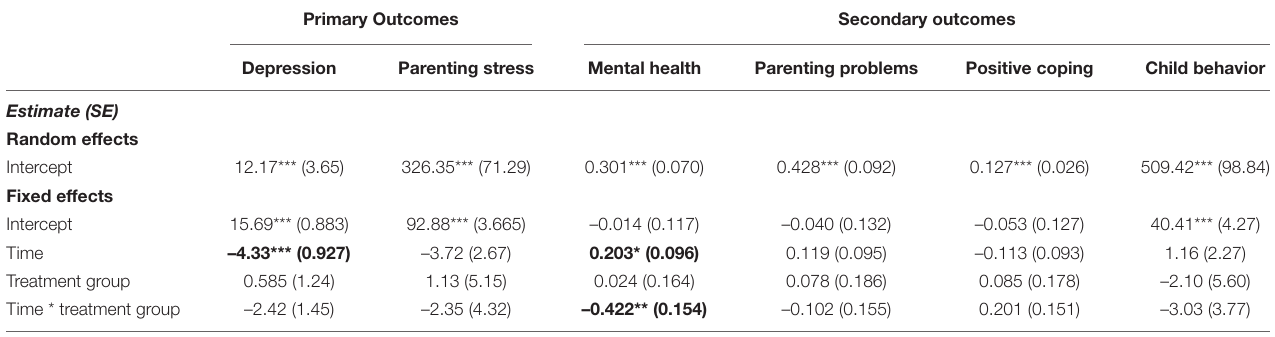
TABLE 4 | Pre-post mixed model results for outcome